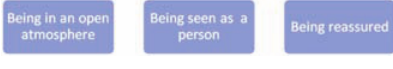
Figure 1. Being in an oasis: a restorative and reassuring place.